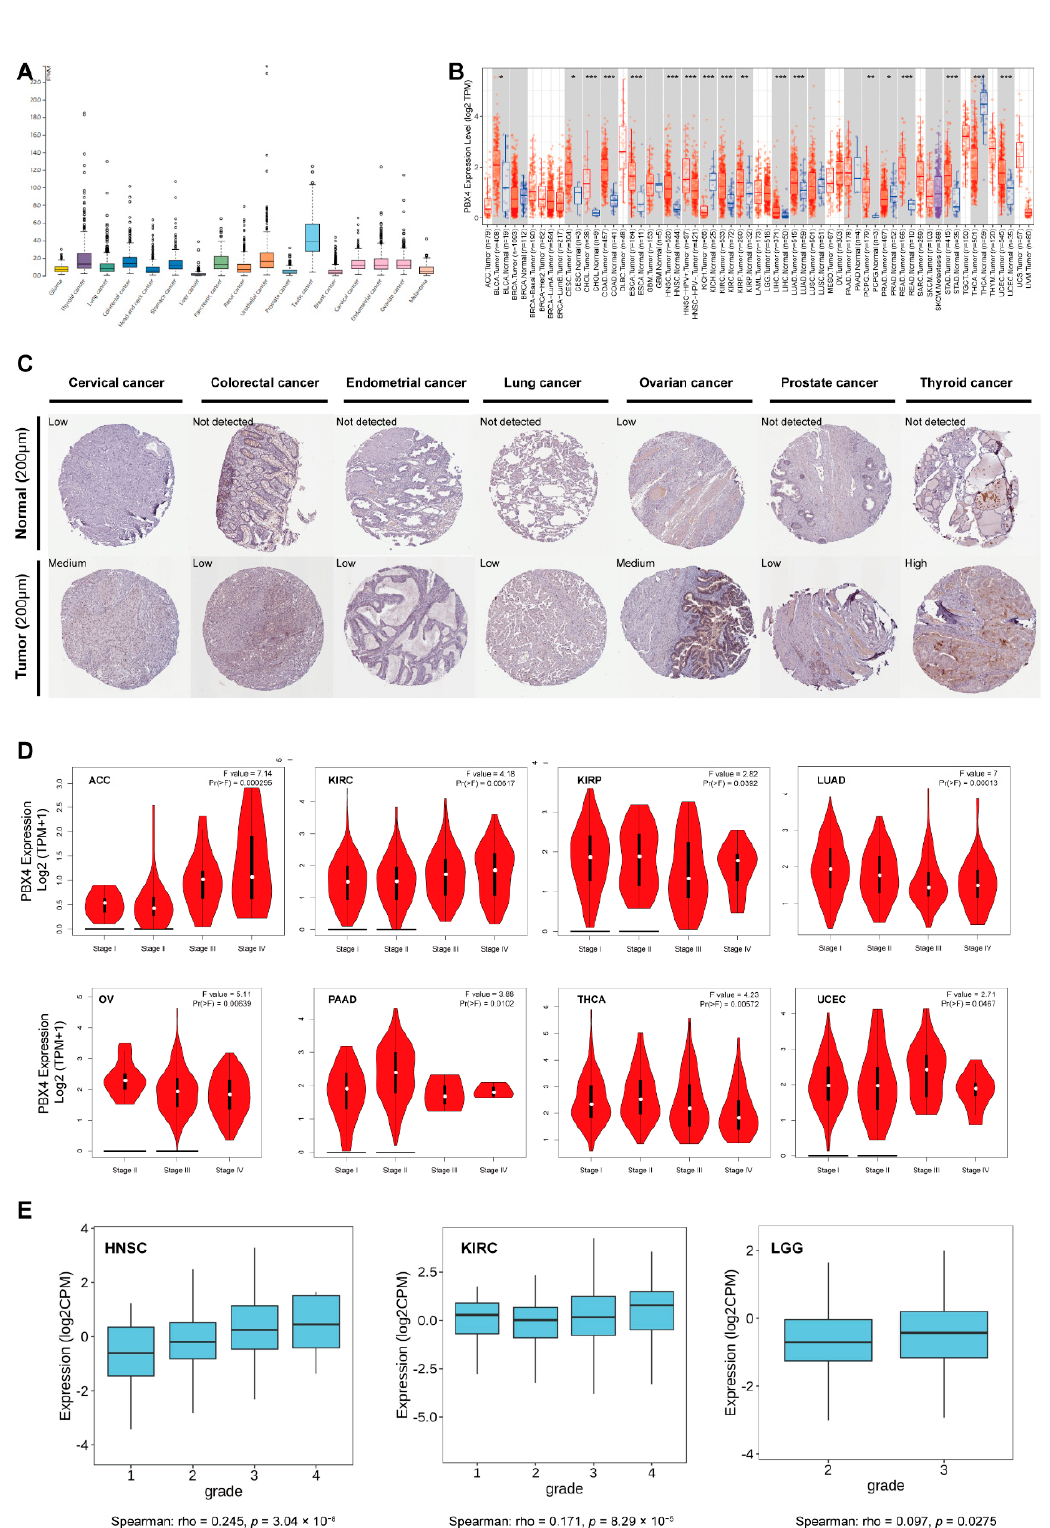
Figure 3. PBX4 expression levels in various human cancers. ( A ) The PBX4 mRNA expression in cancer tissues from TCGA database. (FPKM: fragments per kilobase of exon per million reads). ( B ) Differential expression of PBX4 in TCGA cancers and normal tissues of TIMER 2.0 (* p < 0.05, ** p < 0.01, *** p < 0.001). ( C ) The immunohistochemistry images of PBX4 in different tumor (down) and paired normal (up) tissues. ( D ) The associations between PBX4 expression and clinical stage in ACC, KIRC, KIRP, LUAD, OV, PAAD, THCA, and UCEC. ( E ) The associations between PBX4 expression and tumor grade in HNSC, KIRC, and LGG.